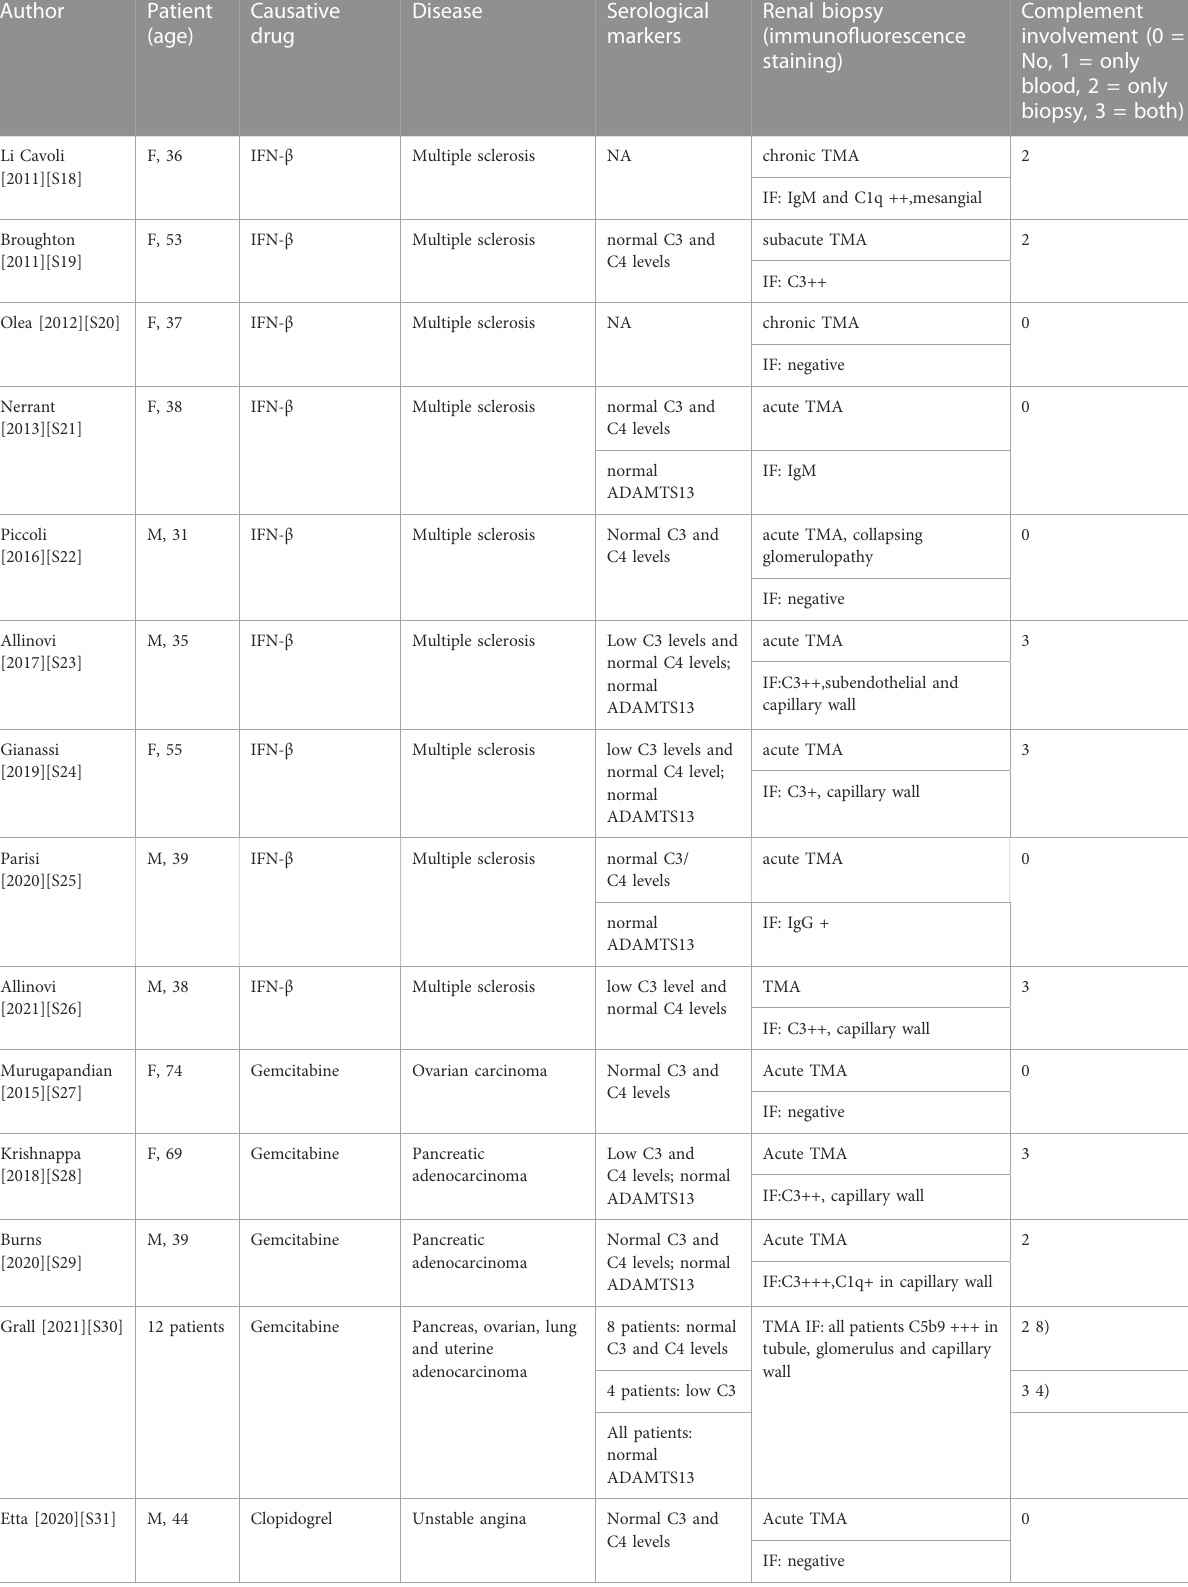
TABLE 2 Complement serum consumption and complement activation in renal biopsies of patients with